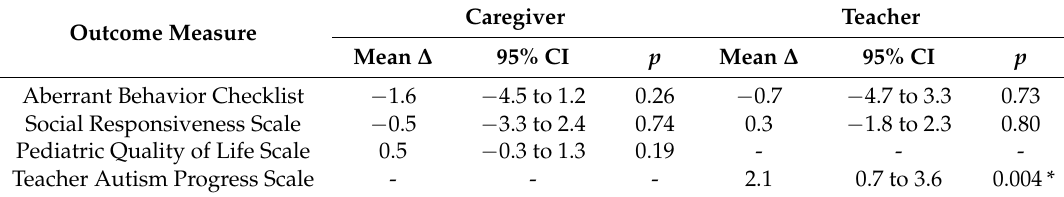
Figure 1. Longitudinal analysis of outcome scores by school quarter and respondent type: ( A ) change in aberrant behavior; ( B ) change in social responsiveness; ( C ) change in pediatric quality of life; and, ( D ) change in teacher autism progress scores (TAPS). Note: decrease in aberrant behavior (ABC) and social responsiveness (SRS) indicate improvement. Table 3. Change of average total outcome scores per unit time by respondent type.